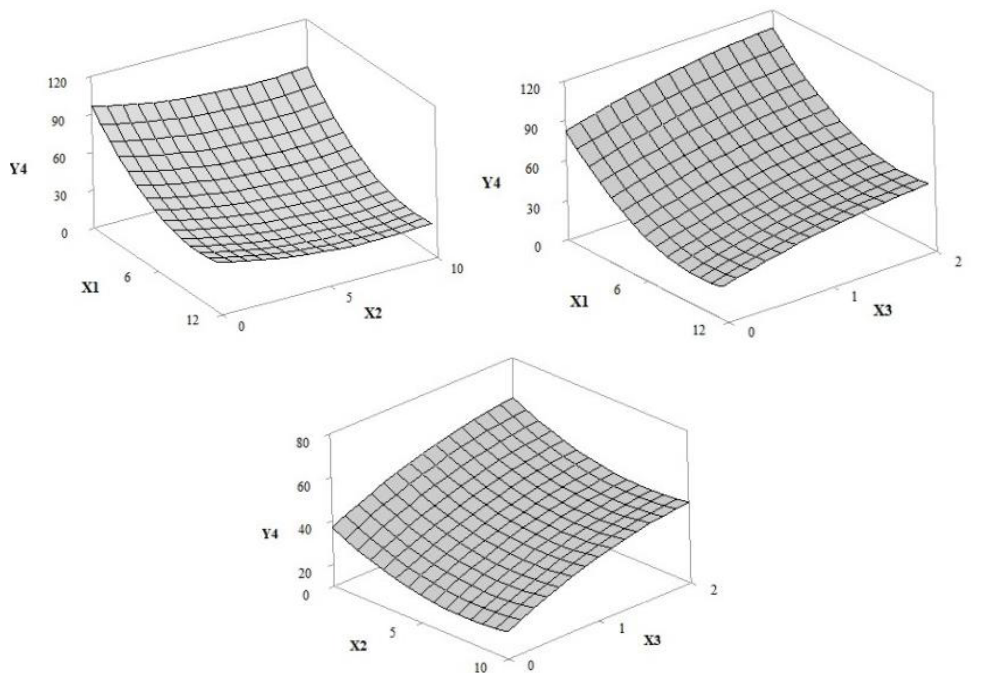
Figure 7. Response surface 3D plot of UVA protection (Y4) as a function of the concentration of UV filters: butylmethoxydibenzoyl methane—UVA, ethylhexyl methoxycinnamate—UVB and ethylhexyl dimethyl PABA—UVB of 0–12% w / w (X1), grape pomace extract concentration of 0–10% w / w (X2) and irradiation time of 1–2 h